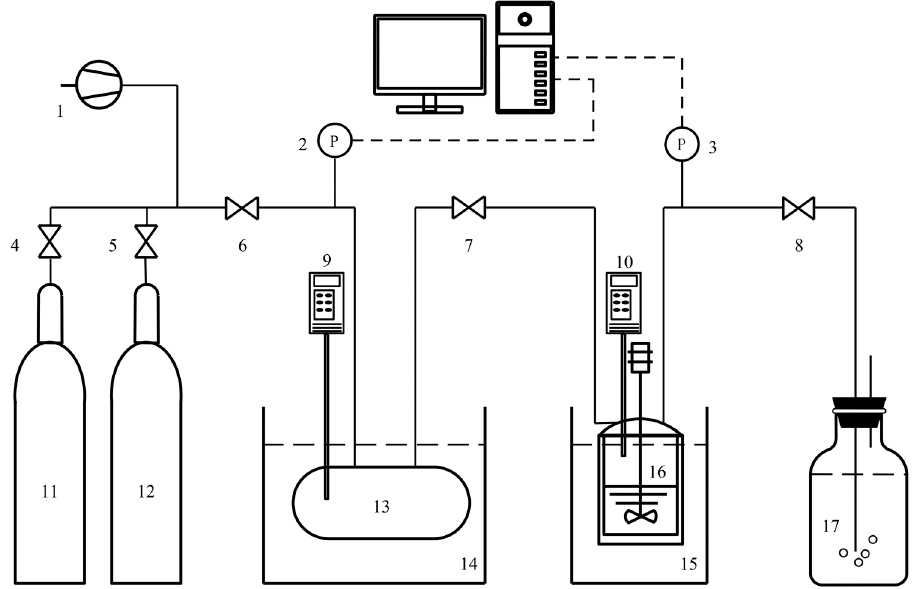
Figure 1. Scheme of the experimental setup: 1, vacuum pump; 2, 3, pressure sensor; 4 to 8, valve; 9, 10, thermocouple; 11, H 2 S gas cylinder; 12, N 2 gas cylinder; 13, buffer tank; 14, 15, water bath; 16, equilibrium kettle; 17, gas scrubber.